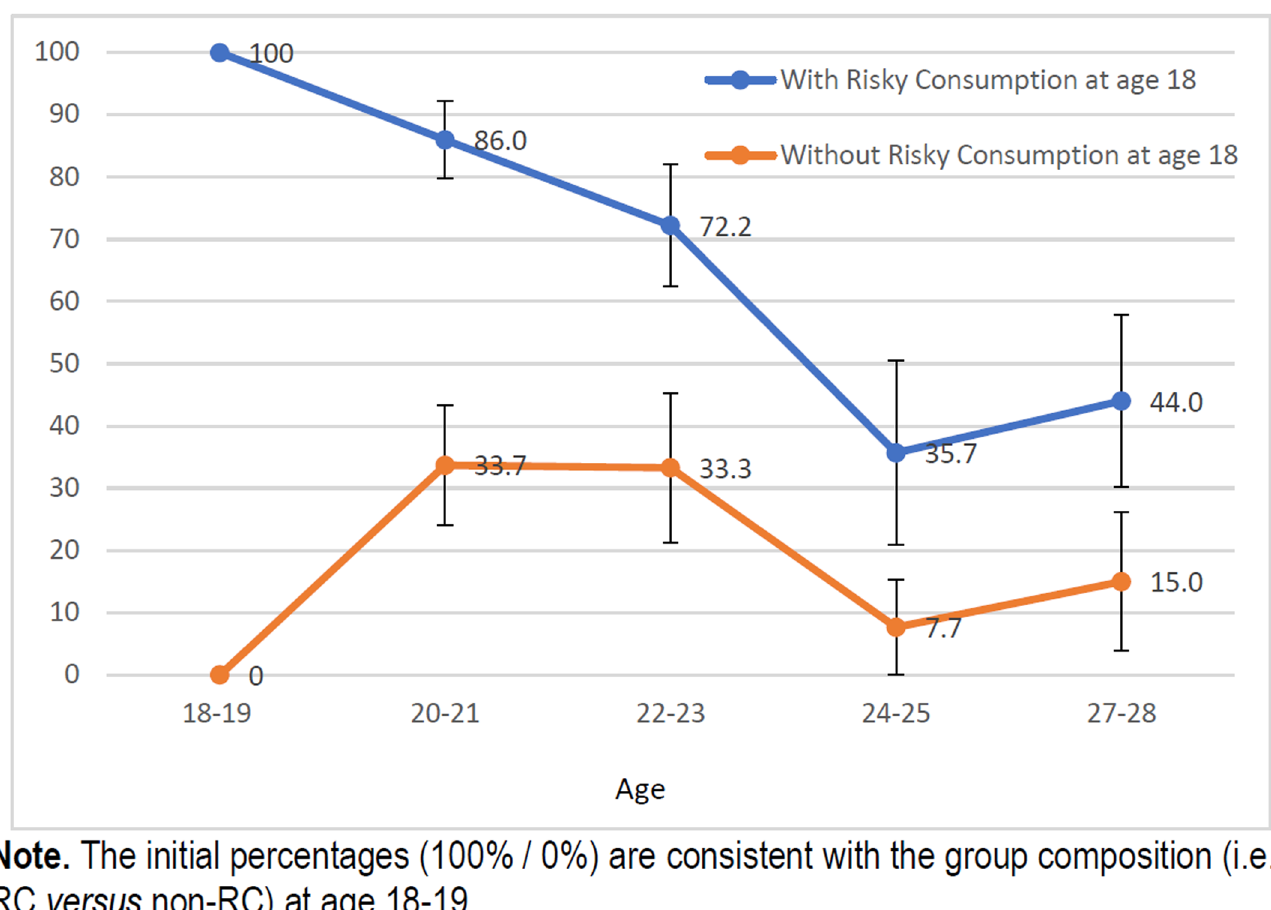
Fig 3. Trends in prevalence of risky consumption (%) among men who already partook and who did not partake in risky consumption at age 18–19.